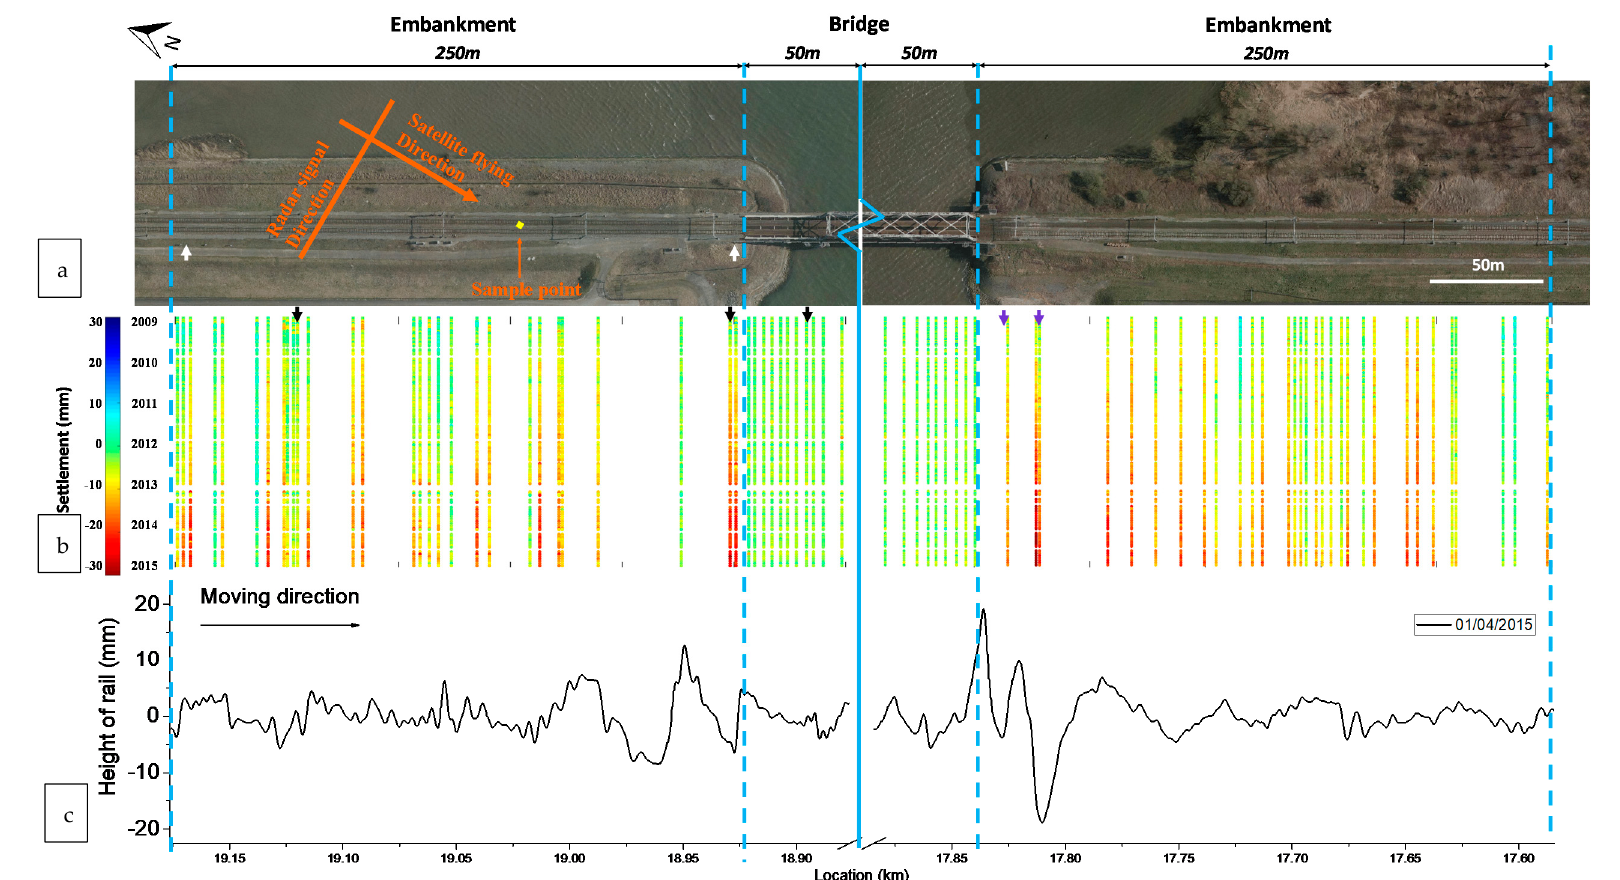
Figure 7. Measurement results of the transition zone: ( a ) Top-view photograph; ( b ) Settlement profile measured the satellite system; ( c ) Alignment measured by the measuring coach. The middle parts of the bridge are abbreviated. The yellow square indicates the sampling resolution (3 × 3 m). The satellite flying direction and radar signal direction are indicated. Write arrows are the locations where DIC measurements were performed. Black arrows are the points collected in Figure 8. Purple arrows are the locations of the expansion joints shown in Figure 11.